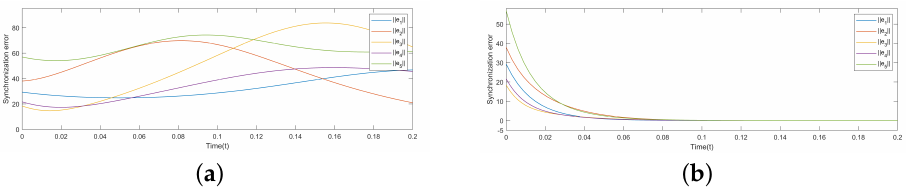
Figure 3. Inter-layer synchronization (RLS) errors. ( a ) The two − layered network without control. ( b ) The two − layered network under event − triggered control